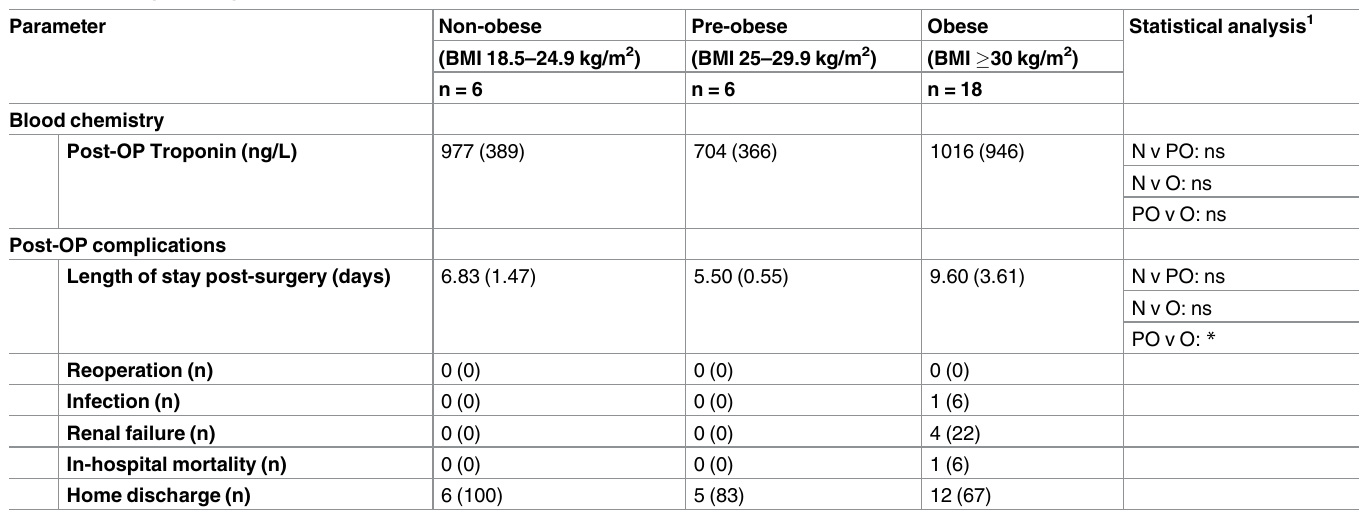
Table 5. Post-operative parameters and